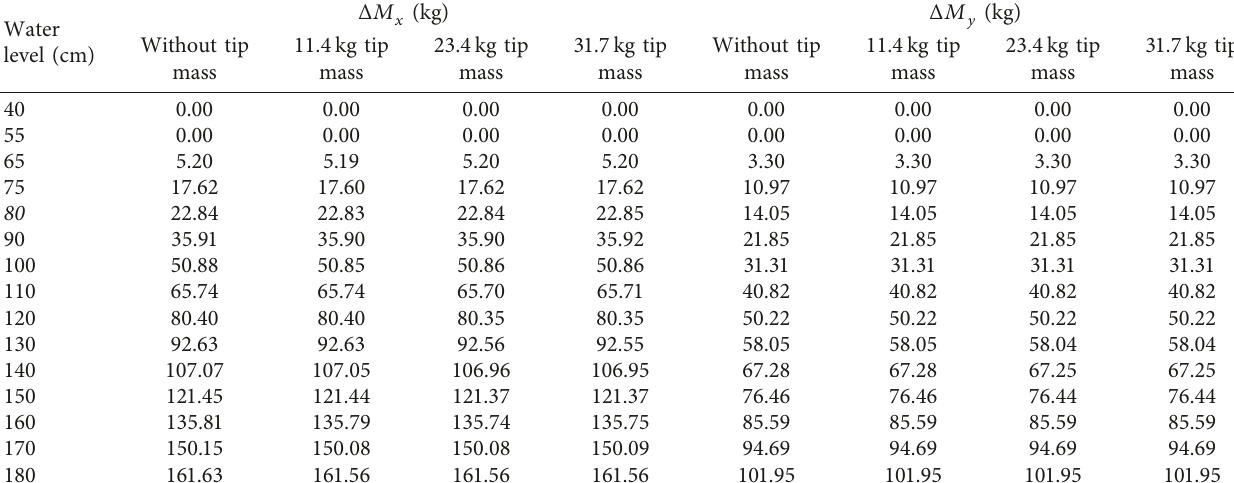
Table 5: HAM along the x -axis and y -axis for the four tip masses in case